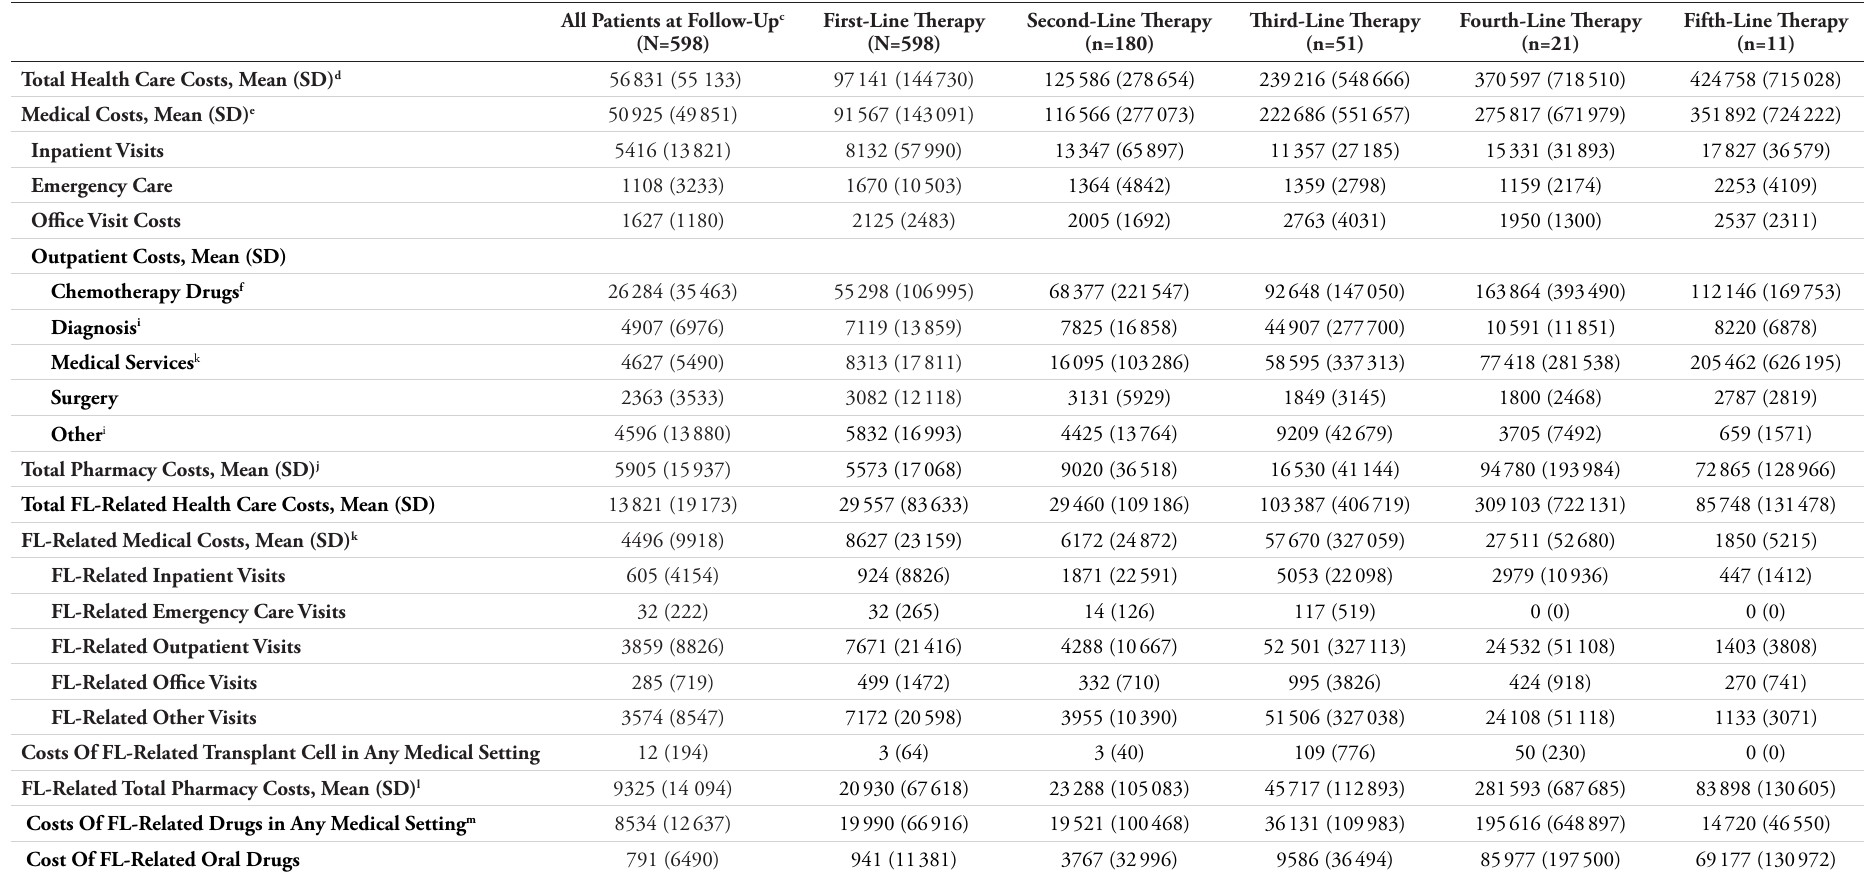
Table 4. Annual Health Care Costs for Patients with FL in the Follow-up Period and Lines of Therapy